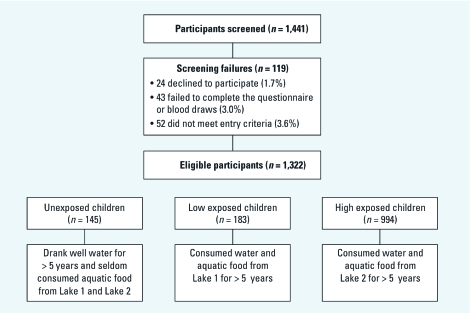
The screening process. Participants were randomly selected from five schools in Fuling Borough, Chongqing.